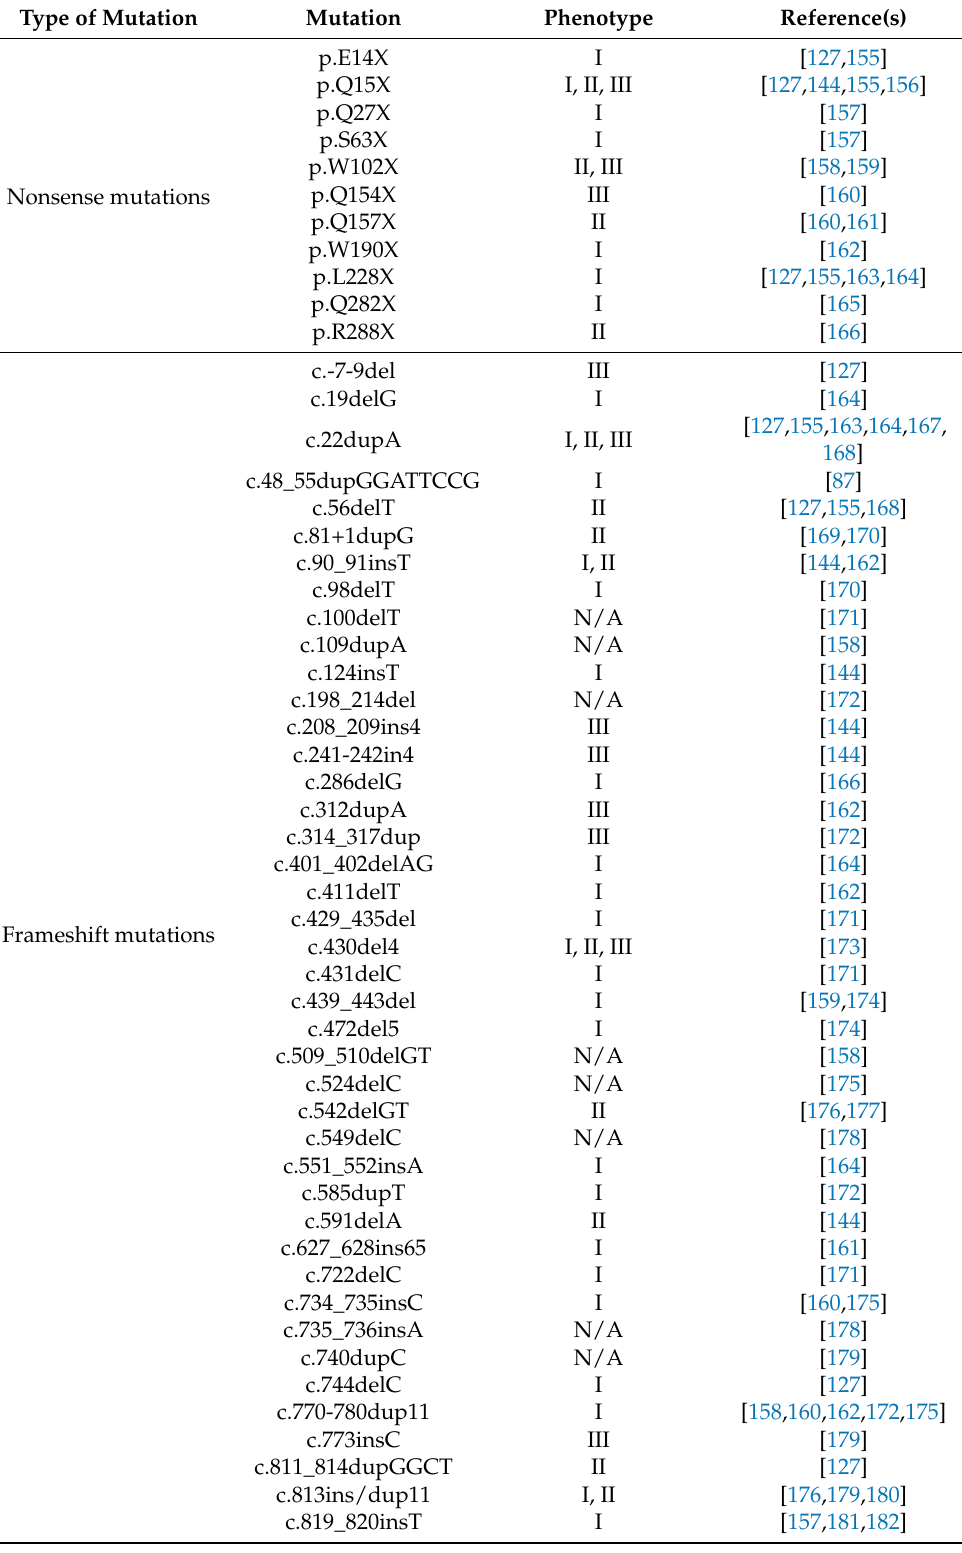
Table 1. Intragenic mutations in SMN1 that have been identified in SMA patients. The nucleotide position for the mutation starts relative to the initiation codon for DNA (NM_022874.2) or amino acid for protein